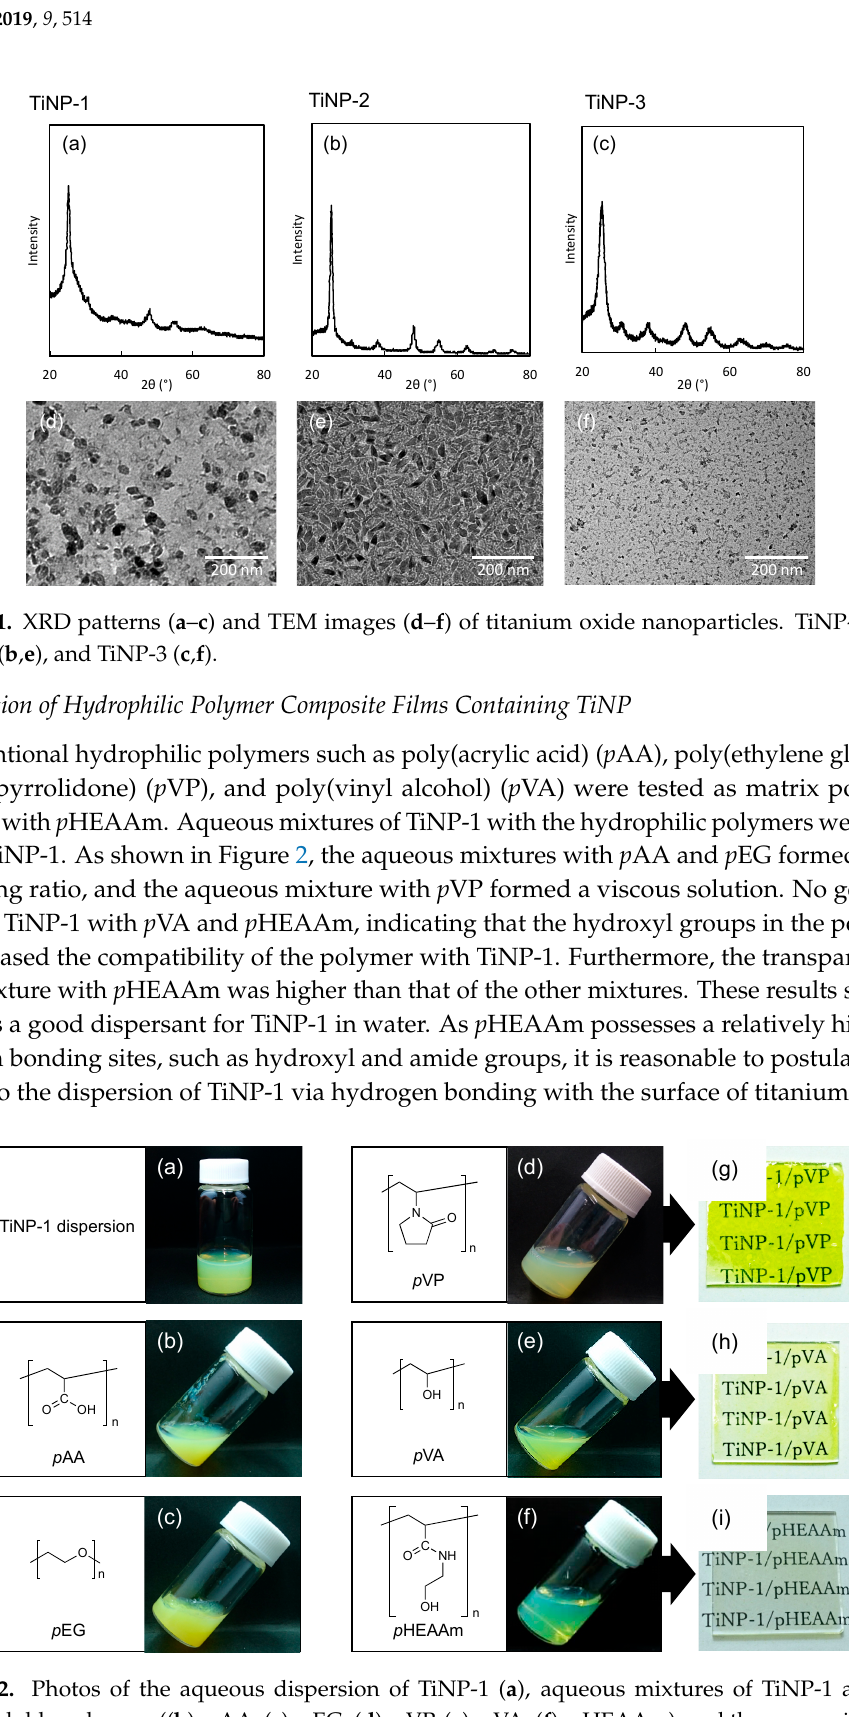
Figure 1. XRD patterns ( a – c ) and TEM images ( d – f ) of titanium oxide nanoparticles. TiNP-1 ( a , d ), TiNP-2 ( b , e ), and TiNP-3 ( c , f ).